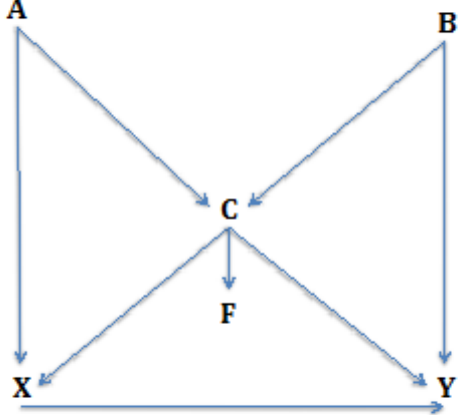
Figure 1. Hypothetical DAG used to illustrate the open backdoor path